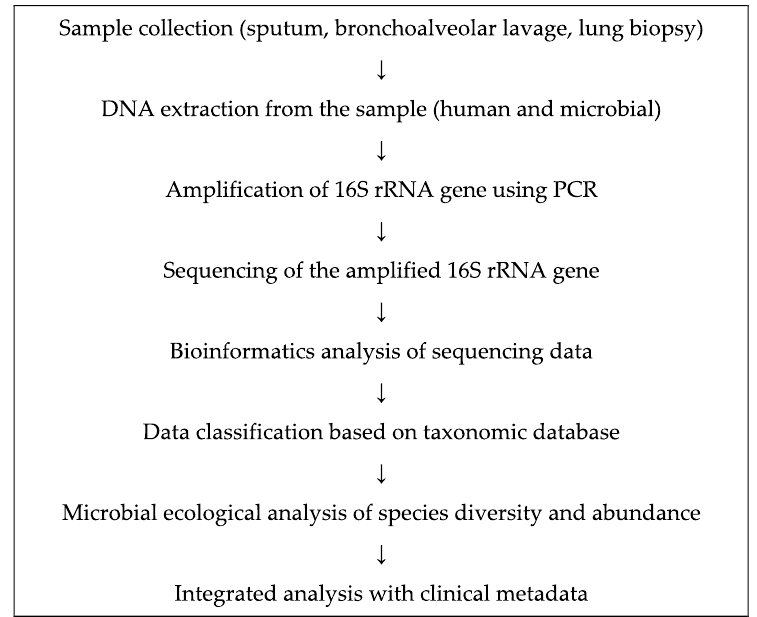
Figure 1. for bacterial analysis of respiratory samples. PCR, polymerase chain reaction. Figure 1. Flowchart for bacterial analysis of respiratory samples. PCR, polymerase chain